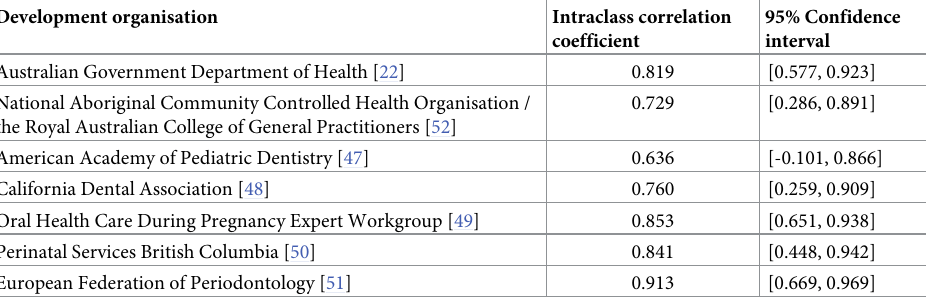
Table 3. Results of the intraclass correlation coefficient analysis of included guidance